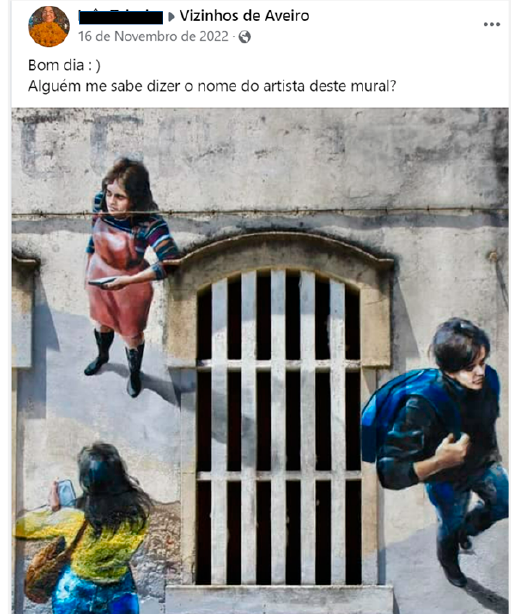
Figure 11. Member inquiring about the authorship of a work (Source: Facebook group Vizinhos de Aveiro/Aveiro Neighbors).